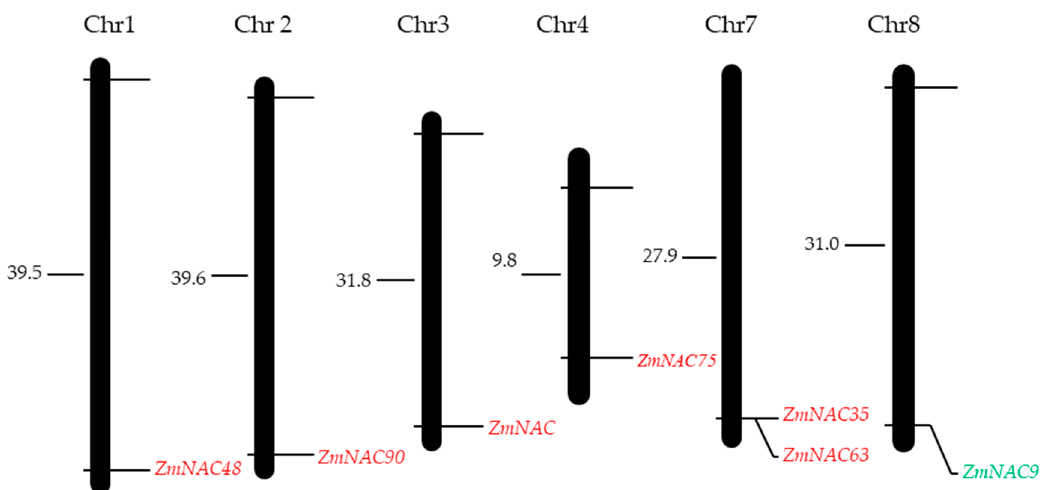
Figure 3. Chromosomal distribution of ZmNAC9 and their homologous genes. ZmNAC9 indicated by green color while homologous by red color. Numbers on chromosomes represented by relative physical distance. Chr—chromosomes.